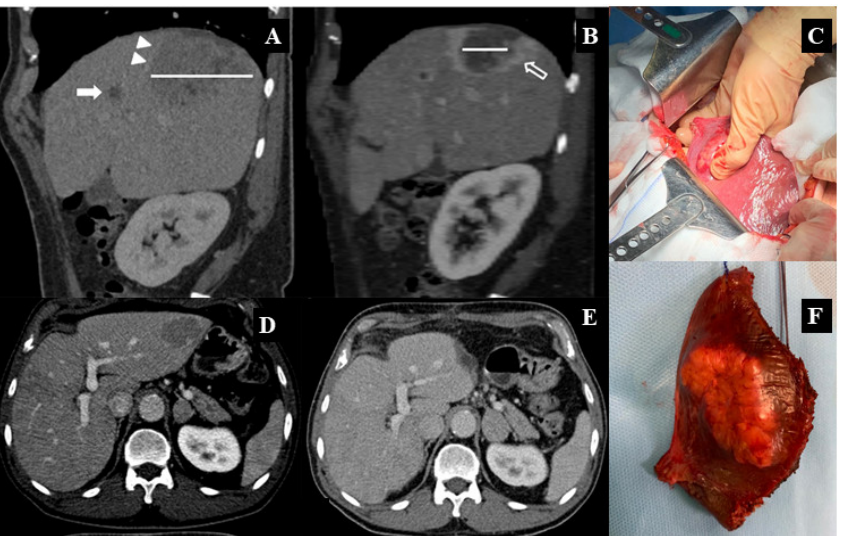
Figure 2. Intraoperative images compared to relative CT scans for one DAA-treated patient. ( A ) Sagittal reconstructed CT image during the delayed phase shows the huge HCC lesion in liver segment VII (9 cm: white line) with infiltration of right hepatic vein (arrowheads) and the tiny satellite nodule in the VIII ◦ segment. ( B ) After radioembolization (SIRT), both lesions present central necrotic area and a fibrotic peripheral rim. The bigger lesion is also reduced in size (white line). ( D ) Axial CT image during the delayed phase shows another HCC lesion across the liver segments II ◦ and III ◦ in a noncirrhotic liver. ( C ) Intraoperative view. ( F ) Surgical specimen. ( E ) After surgery, a small fluid collection is appreciable along the resection margin, without any sign of HCC recurrence.